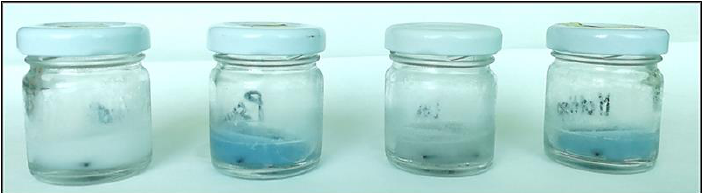
Figure 3. Blue pigment color appearance during the assay of biofilm formation on SS coupons using glass container (72 h, 12 °C). From the left: Control, P. fluorescens pf5, L. monocytogenes LM5, and dual-species system.